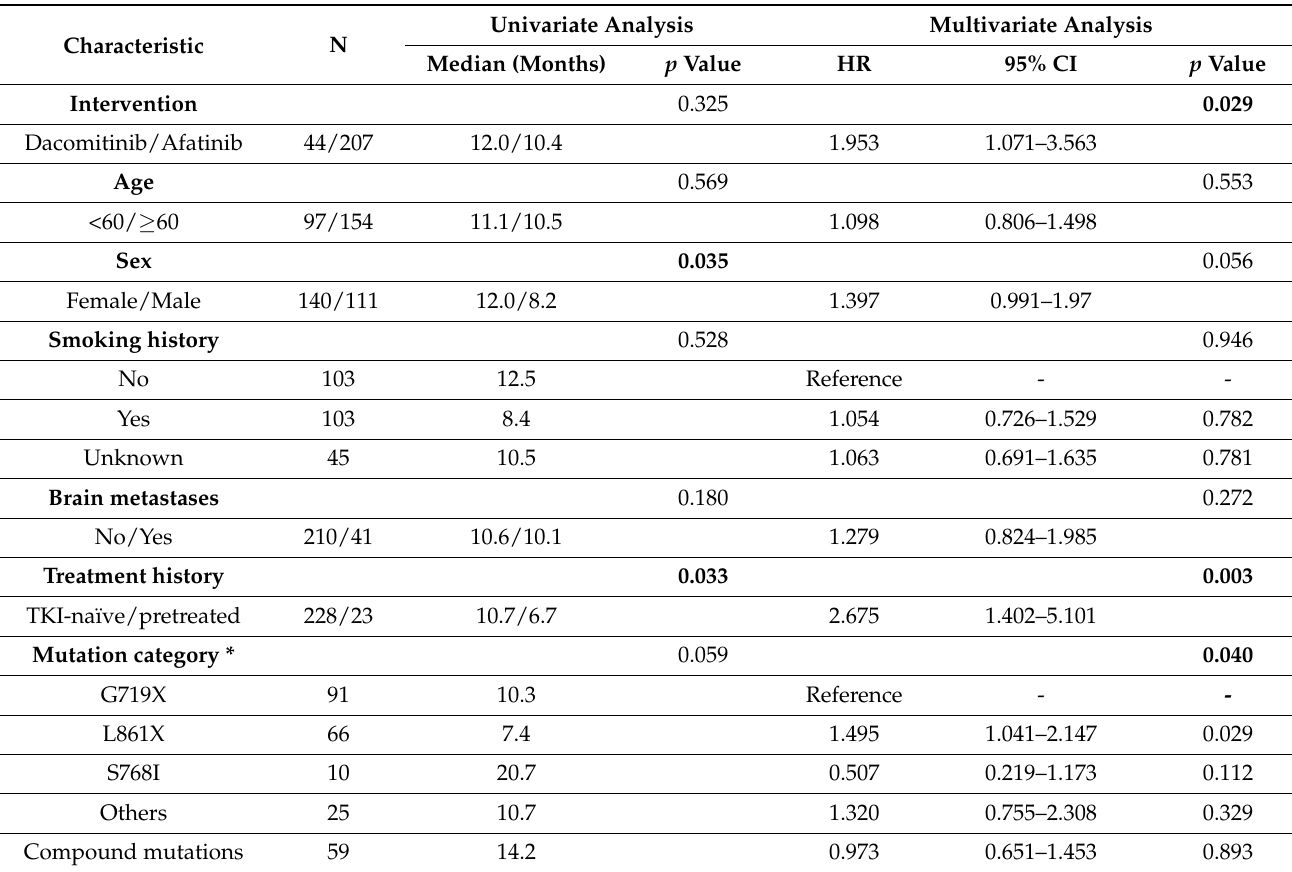
Table 5. Univariate and multivariate analyses of PFS in the pooled cohort of the DC and the ex-AC. (N =